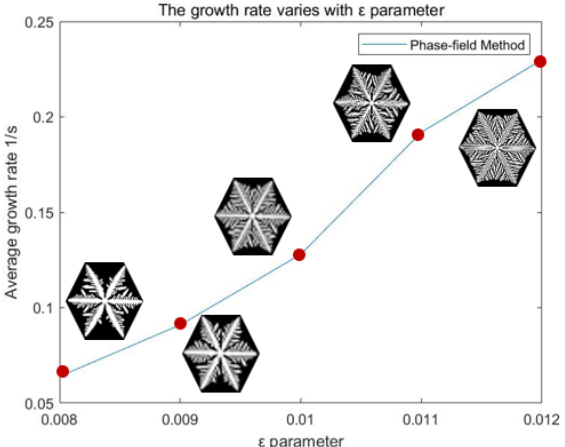
Figure 19. The growth rate varies with the ̄ parameter by PF.